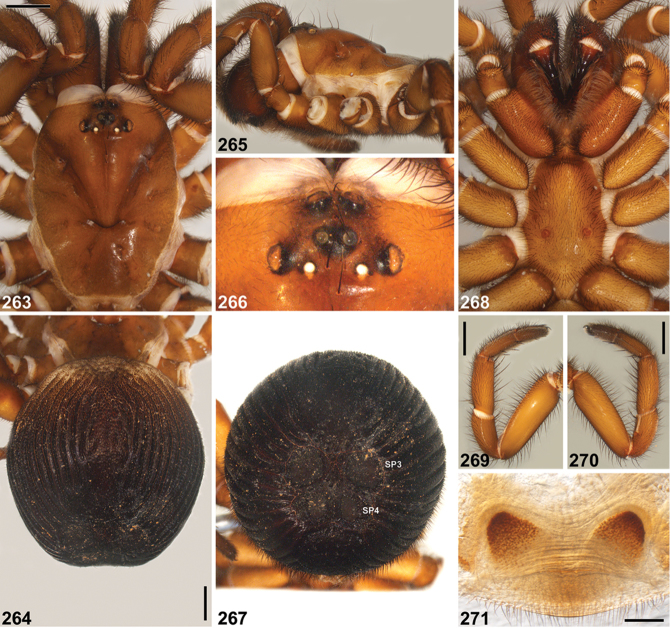

Idiosoma
kopejtkaorum sp. n., female (WAM T108519) from Charles Darwin Nature Reserve (Western Australia; AVW). 263–264 Carapace and abdomen, dorsal view 265 Carapace, lateral view 266 Eyes, dorsal view 267 Abdomen, posterior view 268 Sternum, ventral view 269 Leg I, prolateral view 270 Leg I, retrolateral view 271 Spermathecae, dorsal view. Scale bars 2.0 (263–264, 269–270), 0.5 (271). SP3–4 = sigilla pairs 3–4.